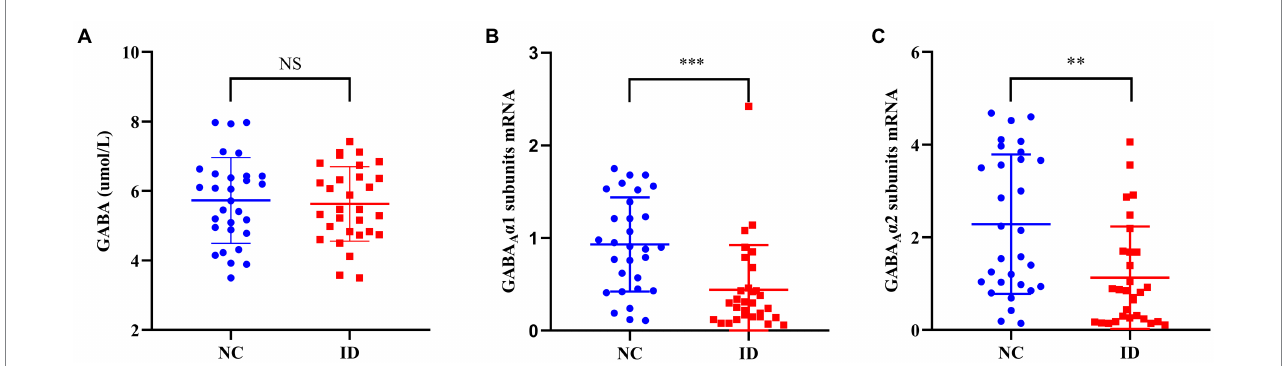
FIGURE 1 Comparison of γ -aminobutyric acid (GABA) levels and the mRNA levels of GABA A receptor α 1 and α 2 subunits between ID and NC. NS, no significant; ID, insomnia disorder group; NC, normal control group. ** p < 0.01. *** p < 0.001.